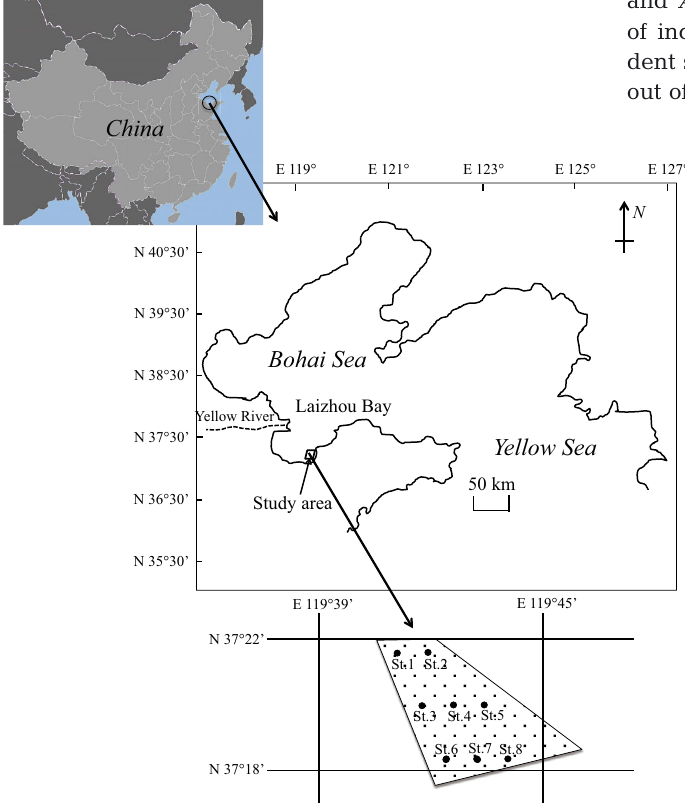
Fig. 1. Model domain in Laizhou Bay, Bohai Sea, PR China. The artifi- cial reef area (~30.65 km 2 ) is denoted by a white trapezoid outlined in black in the nearshore zone of the bay. The Yellow River delta is located in the northwestern region of Laizhou Bay. The survey station is from Stn1 to Stn